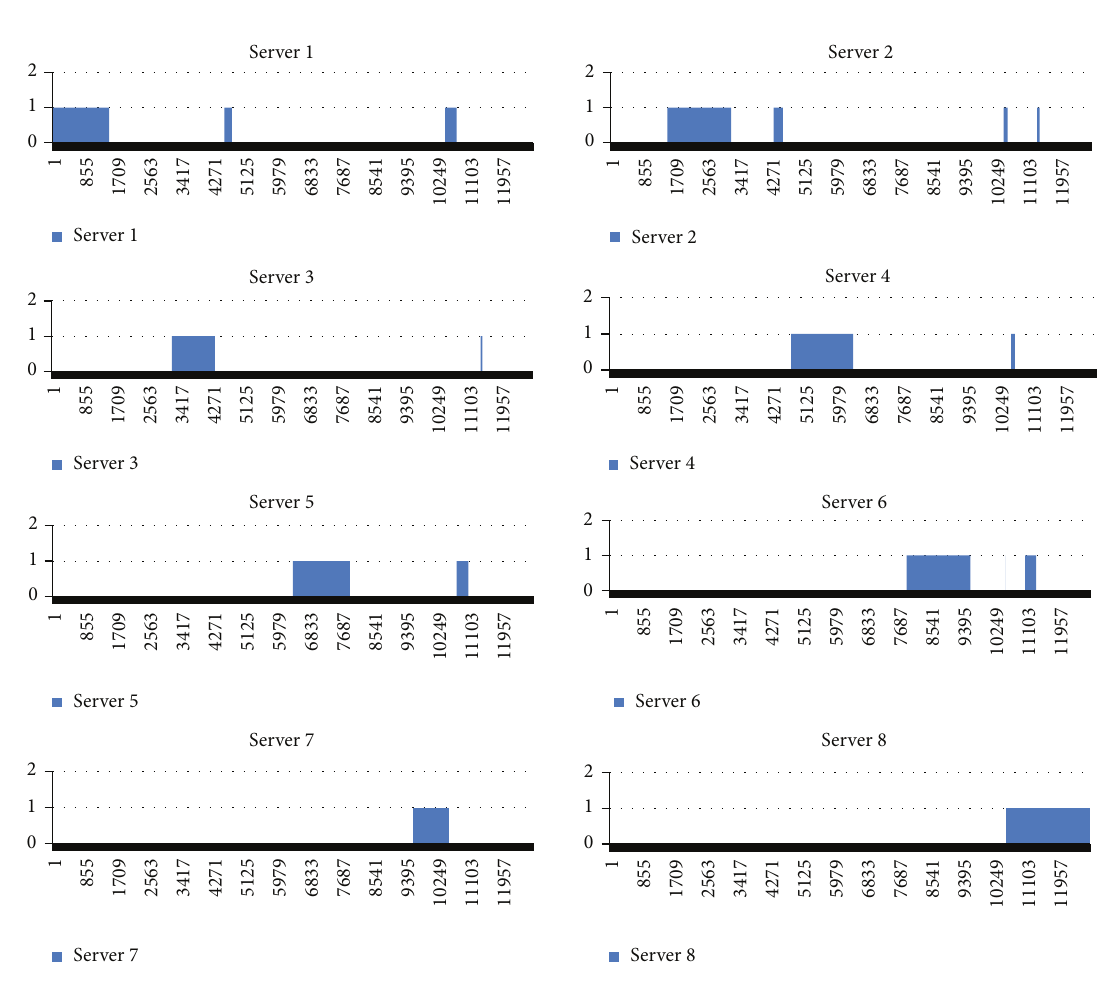
Figure 12: 104 MB file partitions stored in 8 servers based on experience.